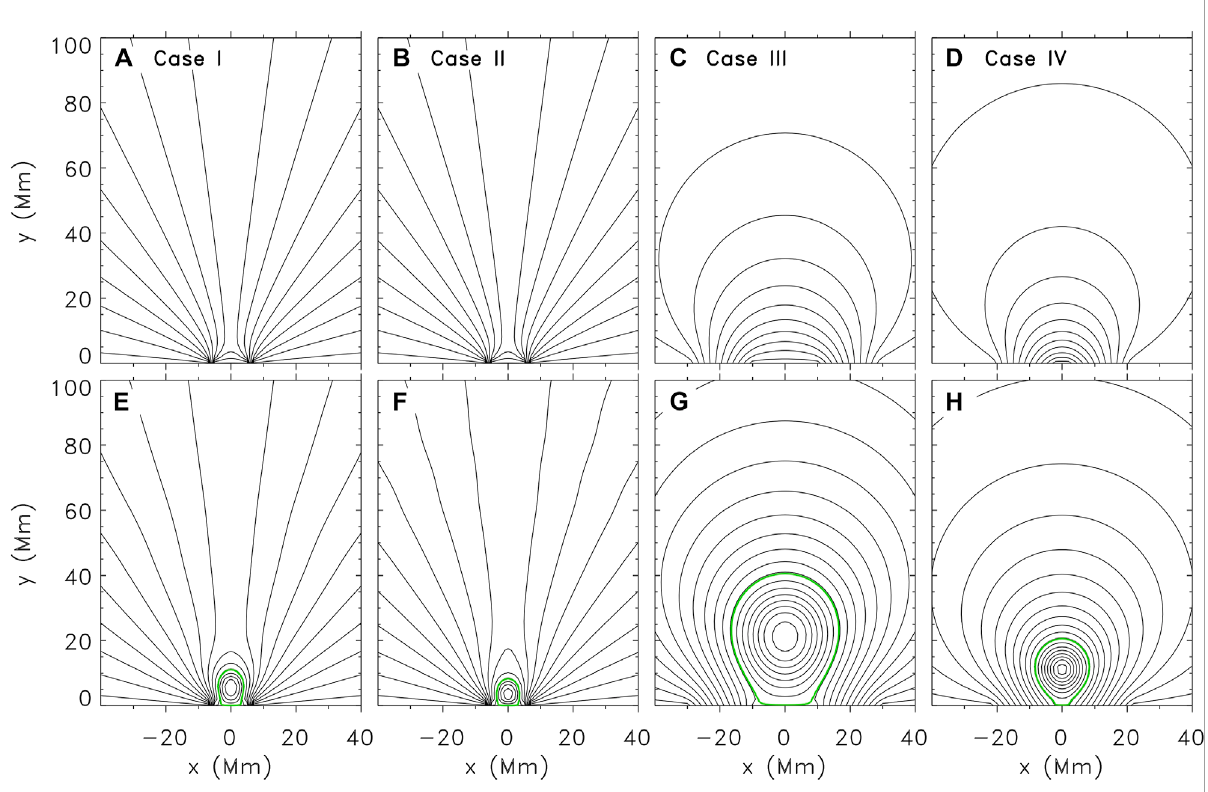
FIGURE 1 The magnetic configurations of the background fields and initial states in the simulation. Panel (A) is the background field for Case I, and panel (E) is the corresponding initial state; panels (B) and (F) , (C) and (G) , (D) and (H) are those for Case II, III, IV, respectively. The black curves are the magnetic field lines, and the green curves mark the boundary of the flux rope. The physical parameters for the background fields and initial states are